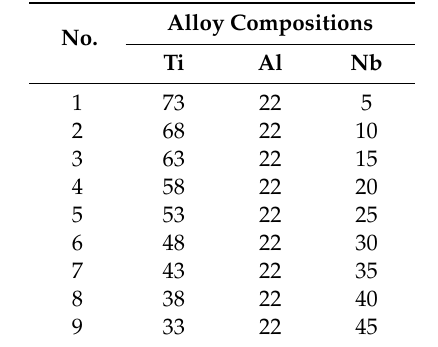
Table 2. The designed alloy compositions in the present